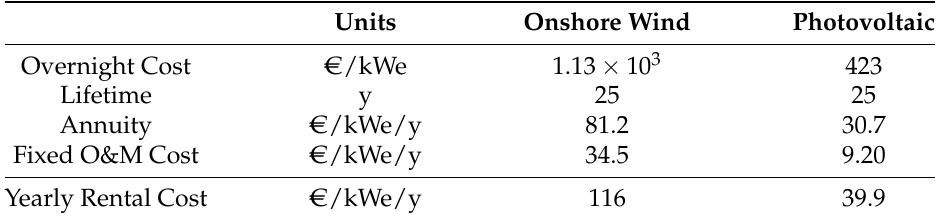
Table 1. Costs and lifetimes used to compute the yearly rental costs for the variable renewable energy technologies (data from Tsiropoulos et al.